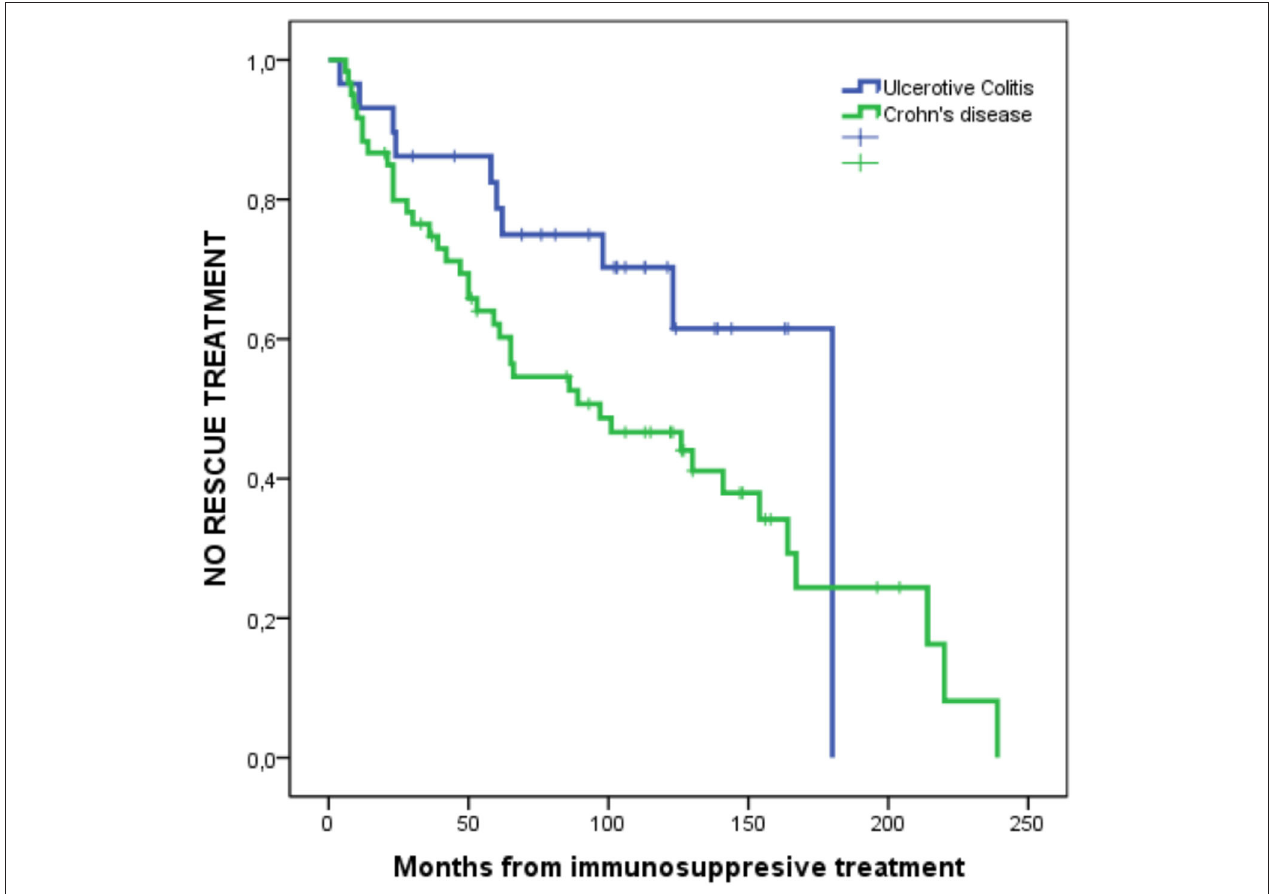
FIGURE 5 | Probability of NO rescue therapy from IMM treatment to the end of follow-up in UC and CD. P = 0.078.